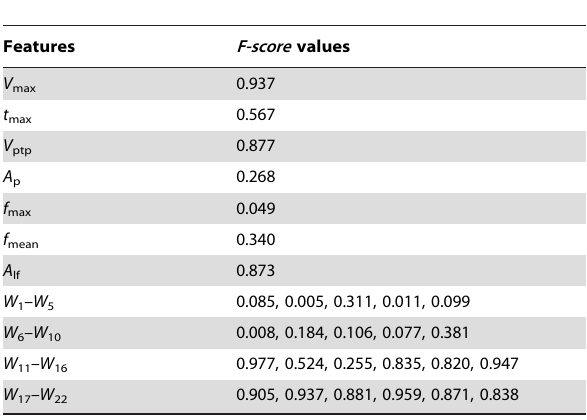
Table 2. The results of feature selection on original 29 features using